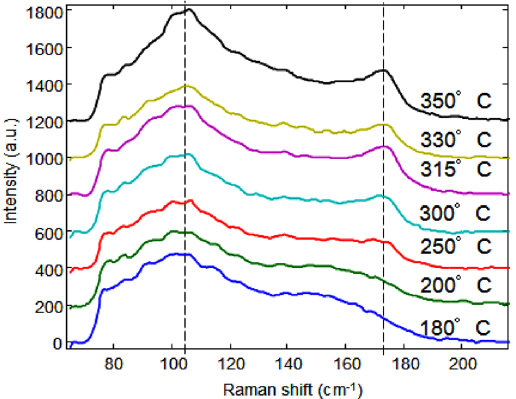
Figure 3. Raman spectra of GST deposited amorphous on SiO 2 , covered with a ZnS:SiO 2 capping layer, and then annealed at different temperatures.